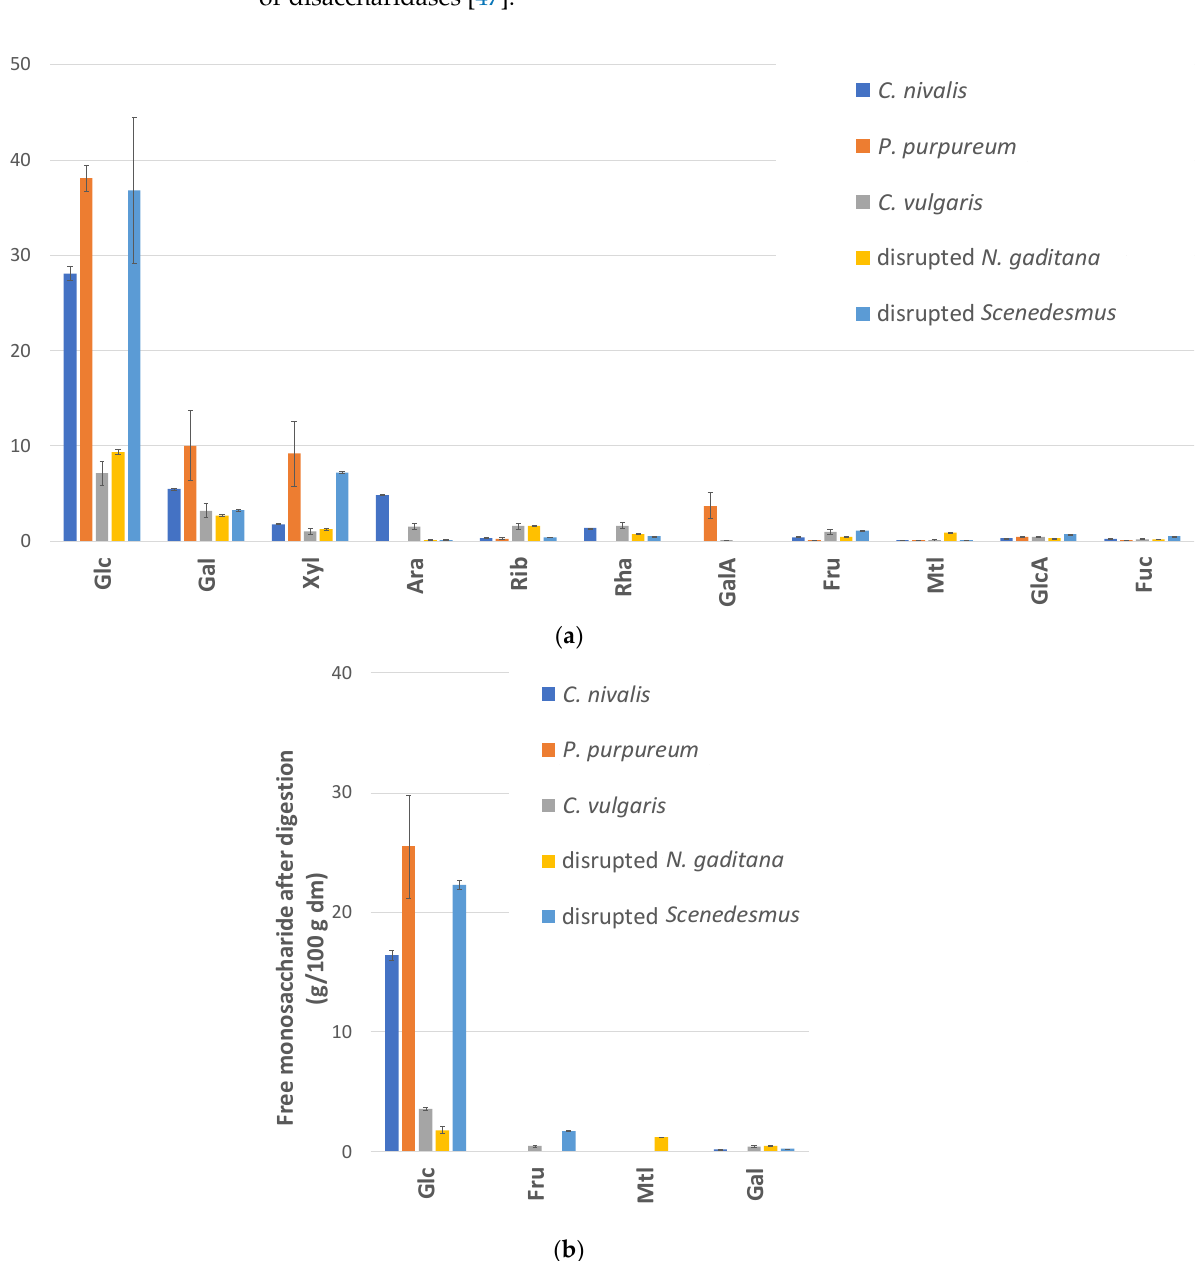
Figure 2. ( a ) Total monosaccharide and uronic acid levels in the initial biomass measured by anion exchange chromatography after acid hydrolysis. ( b ) Free monosaccharides in the liquid digesta after digestion measured by HPAEC. Glc = glucose, Gal = galactose, Xyl = xylose, Ara = arabinose, Rib = ribose, Rha = rhamnose, GalA = galacturonic acid, Fru = fructose, Mtl = mannitol, GlcA = glucuronic acid, Fuc = fucose. Bars and error bars represent averages and standard deviations, respectively. These data are also included in Supplementary Materials Table S1.